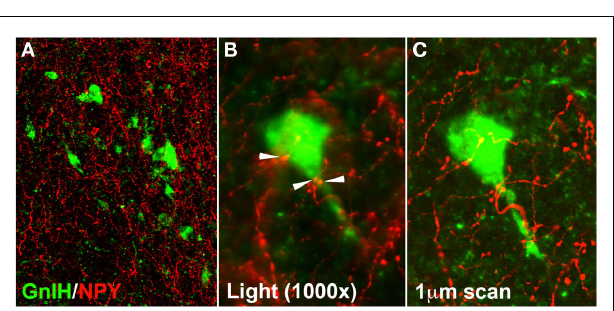
FIGURE 7 | Representative photomicrographs of cells double-labeled for GnIH (red) and NPY (green). A cluster of GnIH-r cells receive extensive NPY projections at 250 × in this confocal scan (A) and a single GnIH-Ir cell with presumptive NPY boutons at 1000 × at the conventional (B) and confocal (C) microscopic